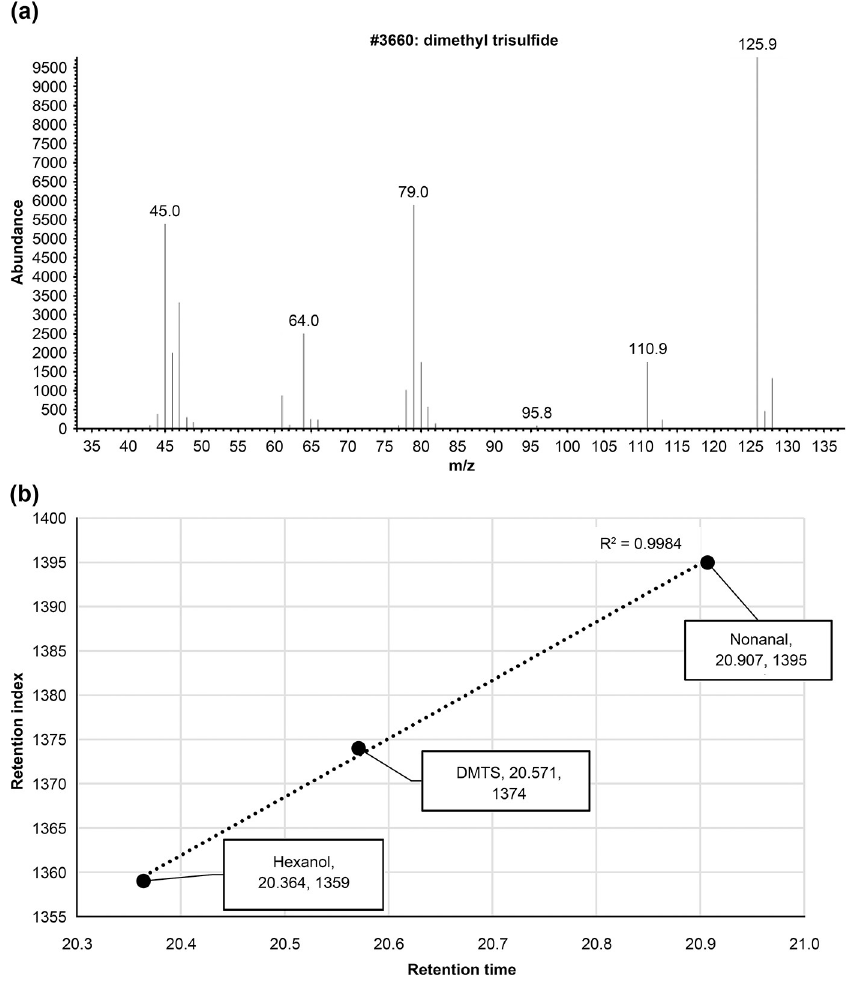
Fig 8. Mass pattern of DMTS and correlations RT and RI. Hexanol and nonanal were detected around the peak of RT = 0.20.571. The correlation between these RTs and the coefficient of determination (RI) of the three components registered in the MS Private Library Database of Takata Koryo Co., Ltd. was R 2 = 0.9984